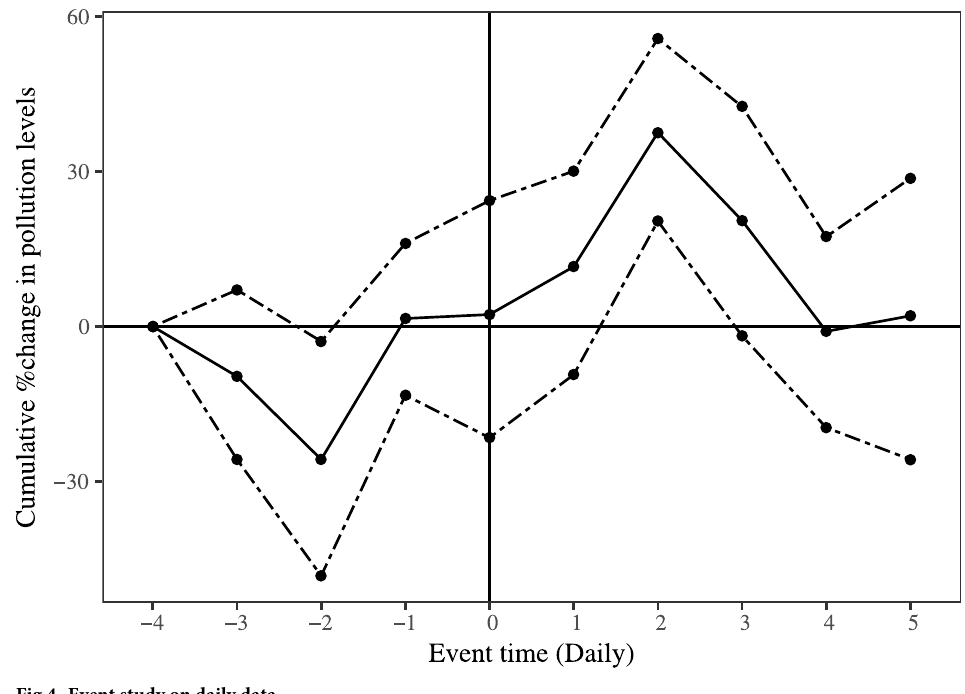
Fig 4. Event study on daily data.